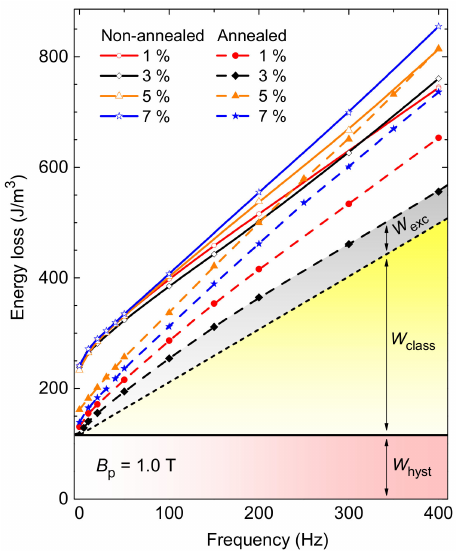
Figure 9. Energy loss behaviour versus magnetizing frequency at B p = 1.0 T in NO electrical steels punched with different cutting clearances before and after annealing. Example of loss decomposition into hysteresis, classical, and excess loss components is provided for annealed steel sample with a cutting clearance of 3% showing the most efficient loss